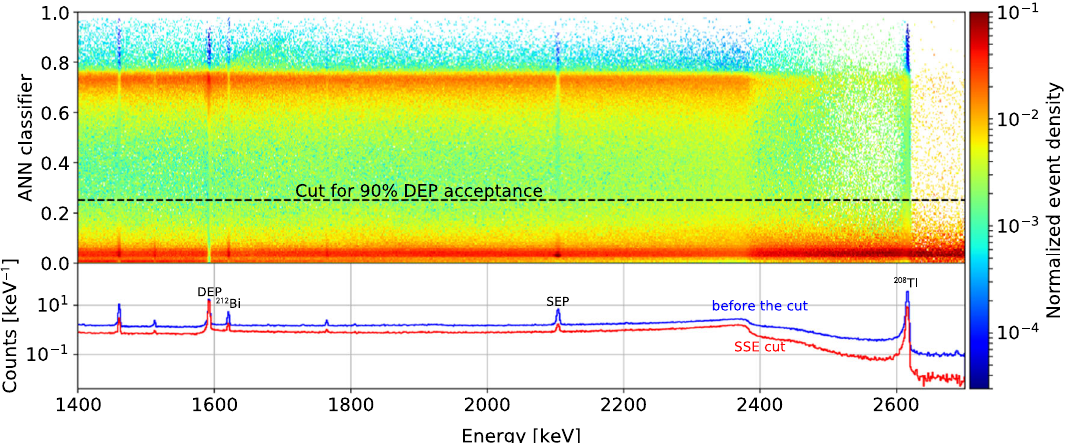
well separated. The numerical values of survival fractions for various peaks are presented in Table 5 (column denoted with MC/Meas.)